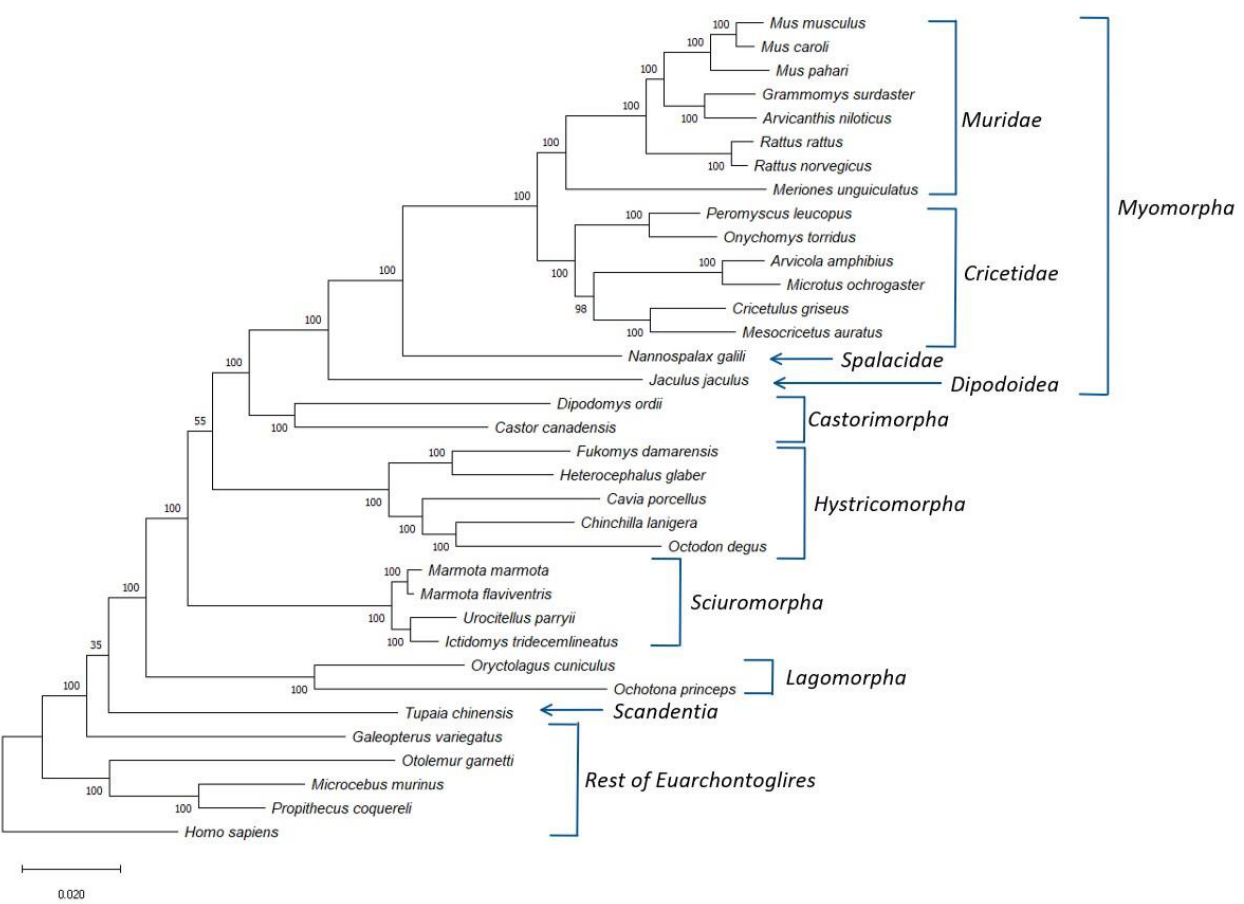
Figure 1. A maximum likelihood distance tree for the Glires species based on concatenated sequences for 25 conserved proteins. The bootstrap score for each branch point is shown at the nodes and numbers on the bar at the bottom indicates the number of changes per position. Major clades within the Glires/Rodentia are labelled and the tree was rooted using the Homo sapiens